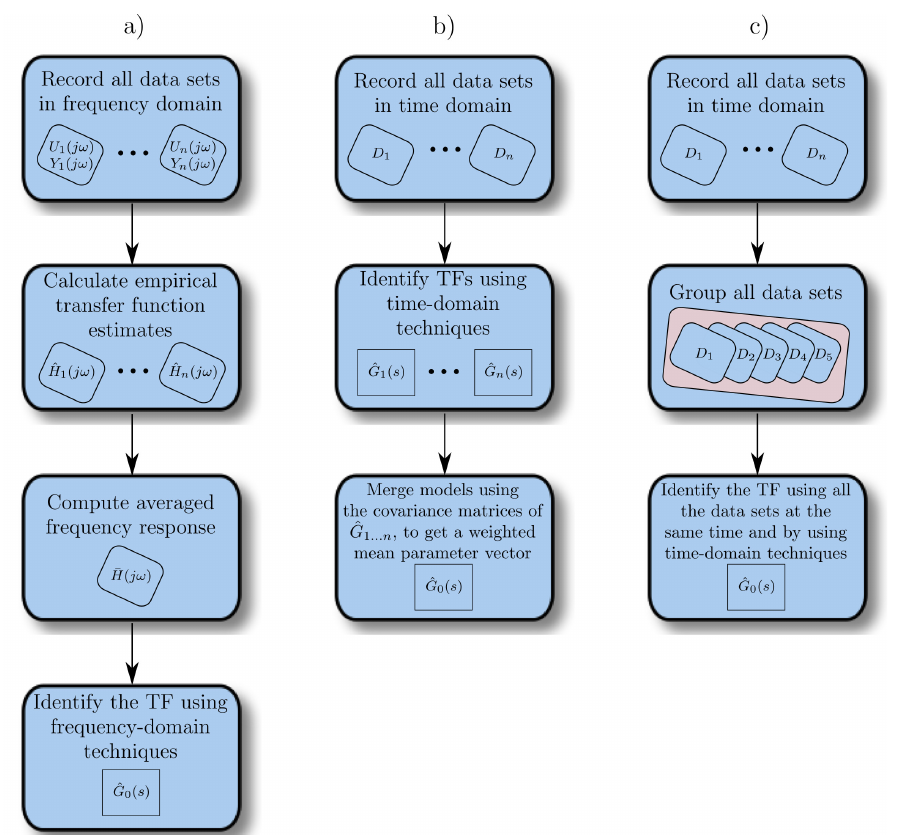
Figure 8. Strategies for linear identification of a WEC model. ( a ) Frequency-domain and averaged frequency response—FDAFR. ( b ) Time-domain and global estimate—TDGE. ( c ) Time-domain and merged